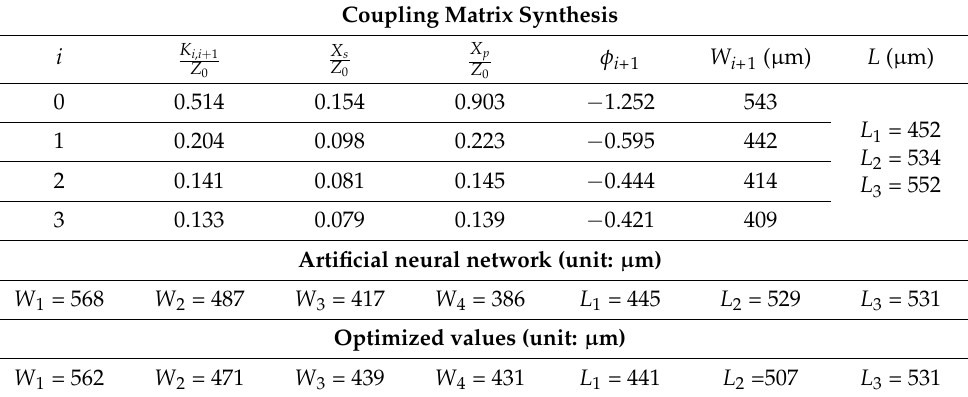
Table 1. Summary of dimensions of the waveguide filter, including the dimensions obtained by the coupling matrix synthesis technique, the dimensions from the artificial neural network, and the optimized dimensions using Ansys ®